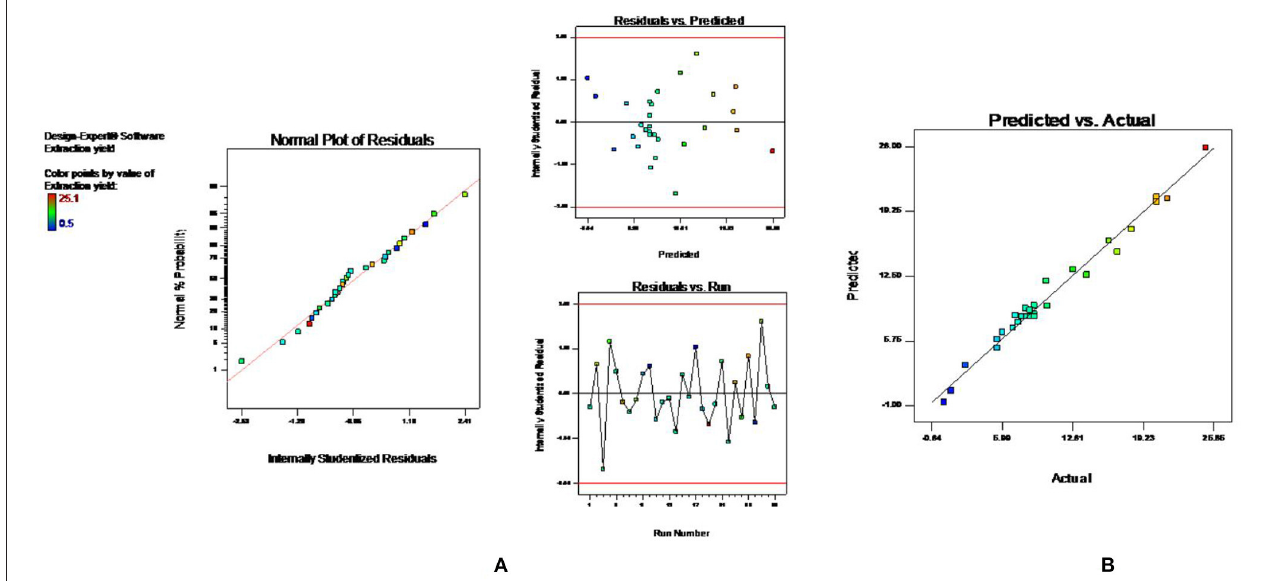
FIGURE 1 | Diagnostic plots to confirm the fitness of developed model in MAE (A) normal plot of residual (B) predicted vs. actual value.